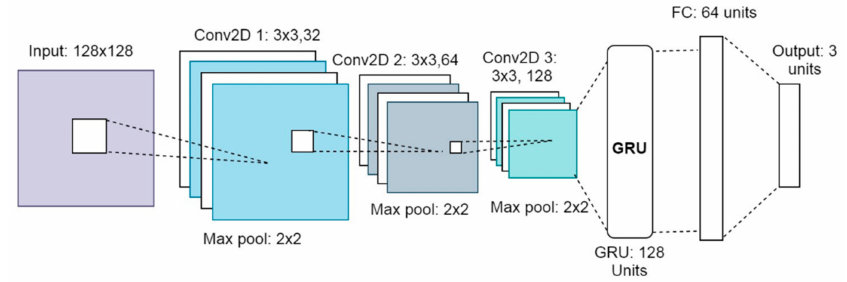
Figure 6. Diagram of the proposed convolutional neural networks (CRNN) model’s